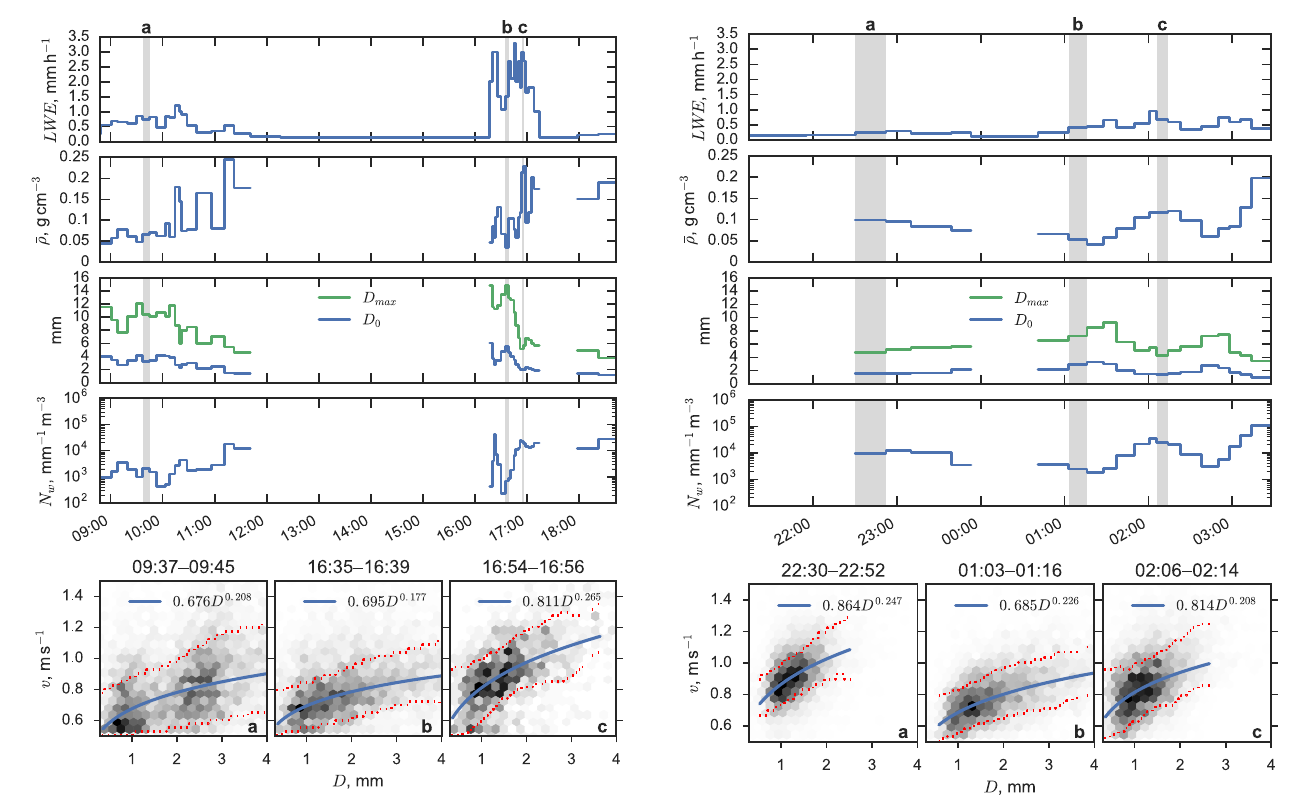
Figure 8. Evolution of snowfall intensity, ensemble mean density and particle size distribution parameters during the night between the 22 and 23 January 2015 with associated ( v , D ) from three se- lected time intervals (highlighted in grey). The red dashed lines mark the upper and lower velocity limits where for a given D , the KDE value is higher than half